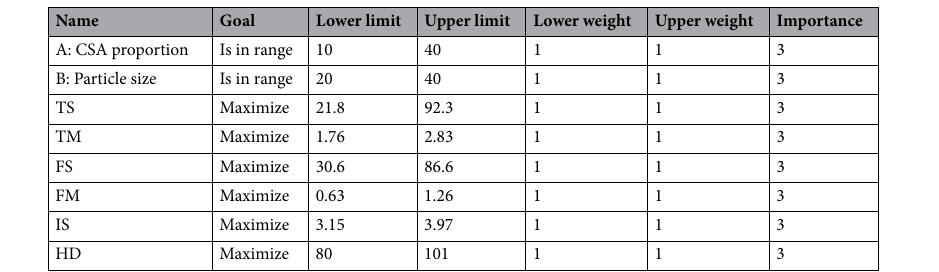
Table 10. Goals and range for the optimization.